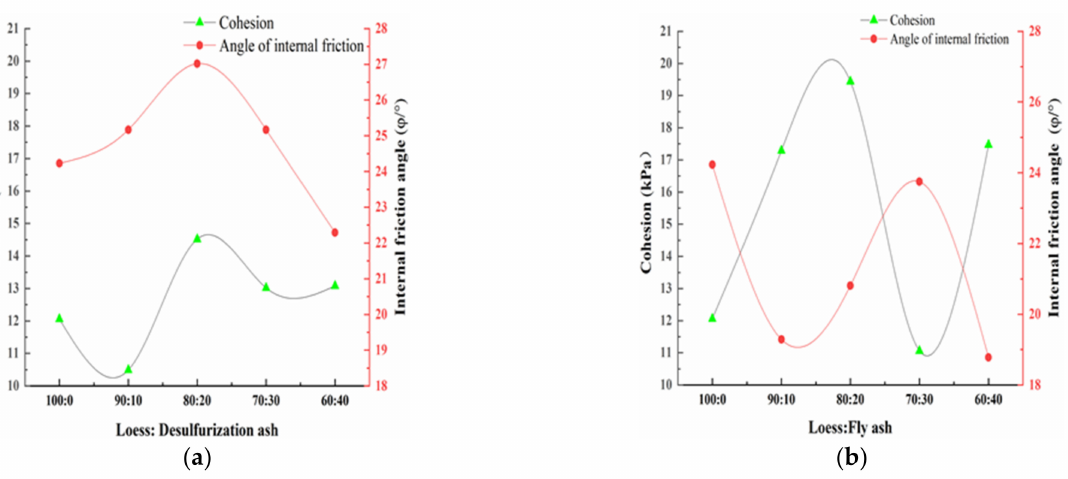
Figure 8. Curves of strength parameters of the loess modified by different solidified materials. ( a ) Desulfurization ash; and ( b ) fly